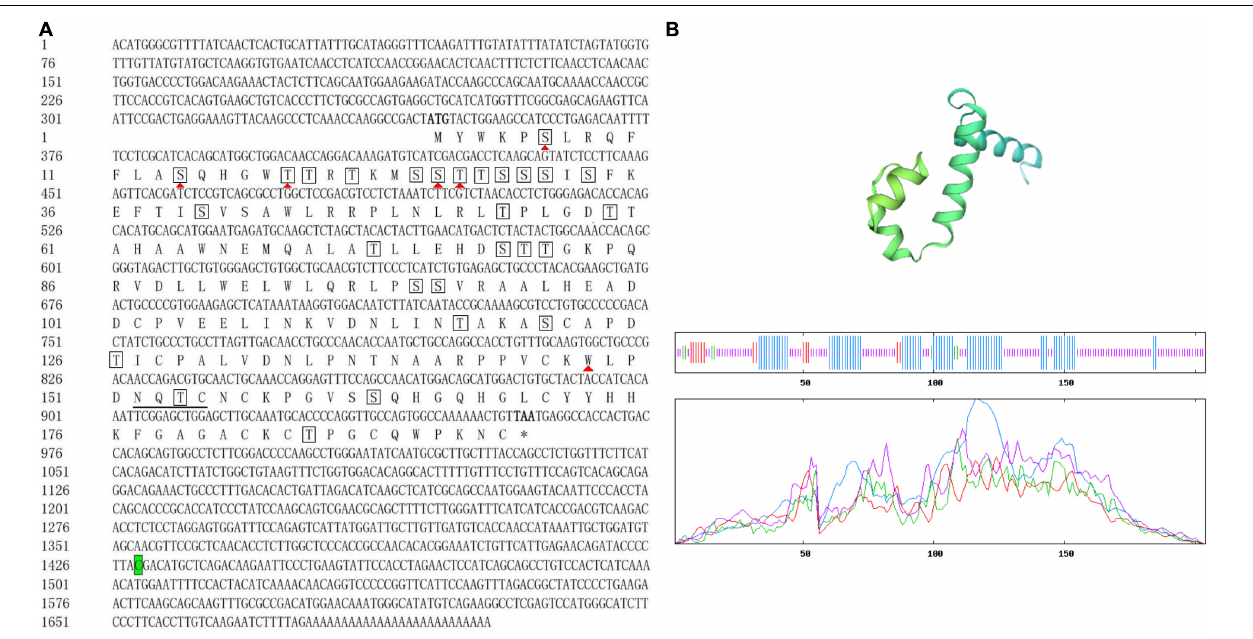
FIGURE 2 | Sequences of full-length complementary DNA and deduced amino acids (aa) of Sp-Pol . The number of nucleotide and amino acid are listed on the left side. Start (ATG) and stop codon (TAA) of the open reading frame are both indicated in bold. Termination of aa is denoted by asterisks. Predicted O-glycosylation sites are indicated by red solid triangles ( (cid:78) ). The potential N-glycosylation site (162NQTC165) is underlined. Potential phosphorylation sites are in boxes. Letter with green background indicates the location of sex-specific SNP (SNP1888: C/T) (A) . The three-dimensional (3D) protein structure of Sp-Pol and analysis of the secondary structure. The a-helix (blue), extended strand (red), random coil (purple), and b-turn (green) (B) .